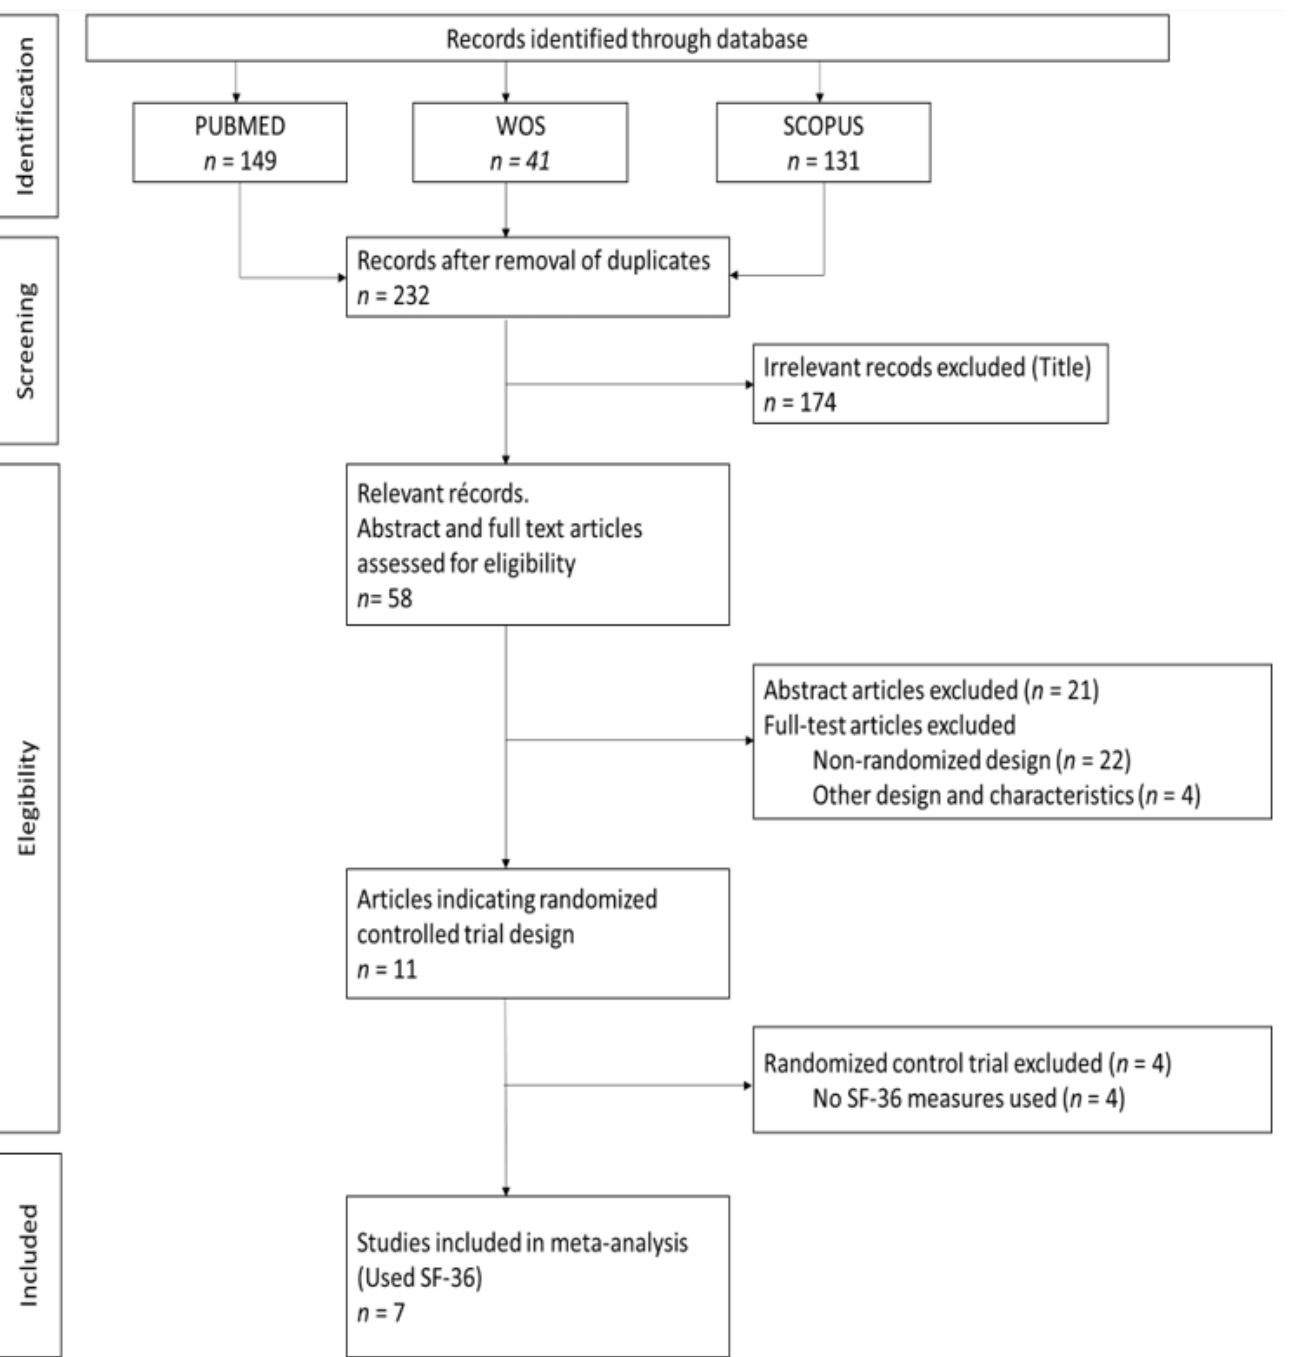
Figure 2. Preferred Reporting Items for Systematic Review and Meta-Analysis (PRISMA) Flowchart. WOS: Web of Science. SF-36: The Short Form-36 Health Survey.